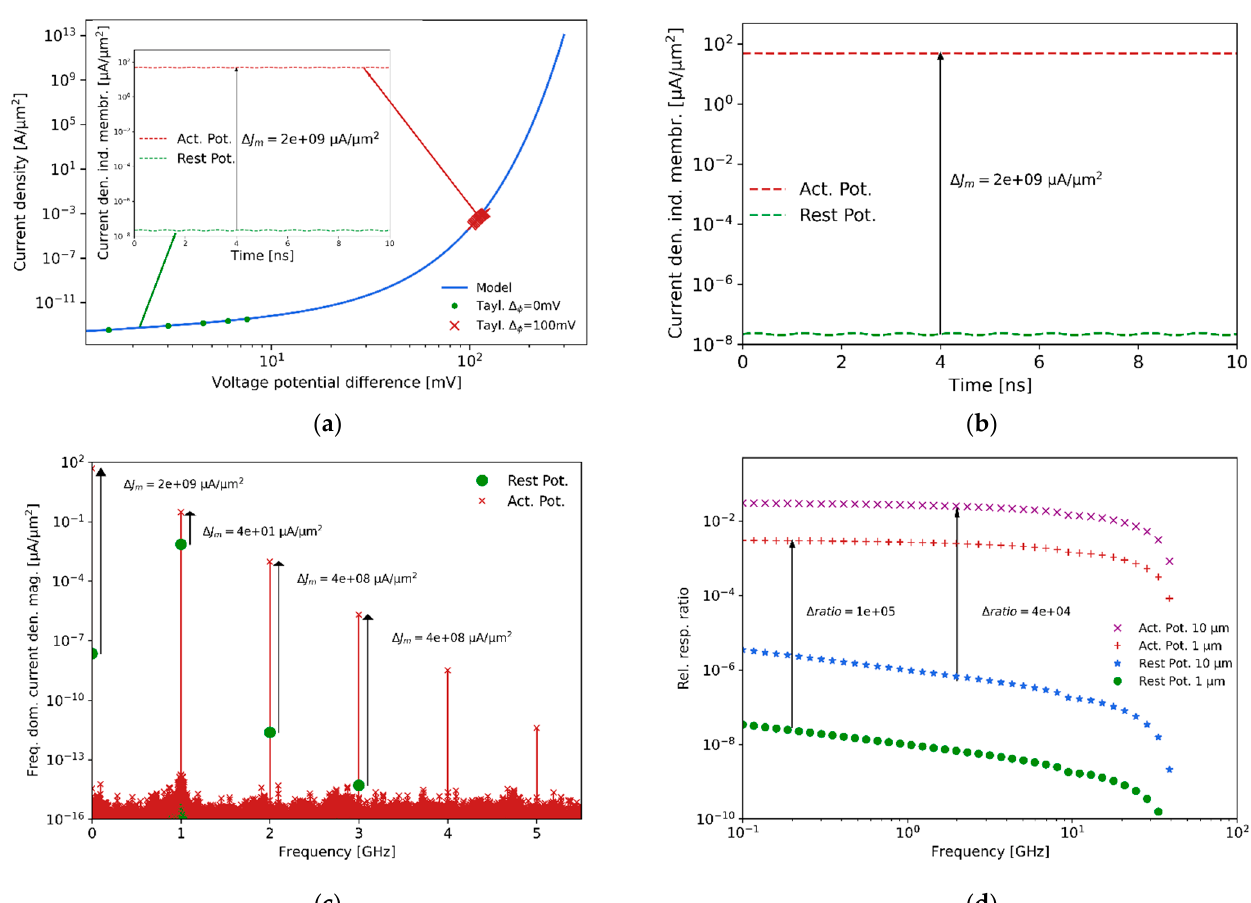
Figure 11. Nonlinear voltage-current response of the membrane potential. ( a ) Current density non-linear dependence with the differential voltage potential. ( b ) Induced current density due to the self-generated transmembrane potential and the impinging microwave field at two different membrane potential states, while (i) at rest and (ii) generating an active potential. ( c ) Frequency domain analysis where the fundamental frequency scattering is due to the membrane. ( d ) Frequency plot of the expected relative second-order responses at rest and at an action potential state.